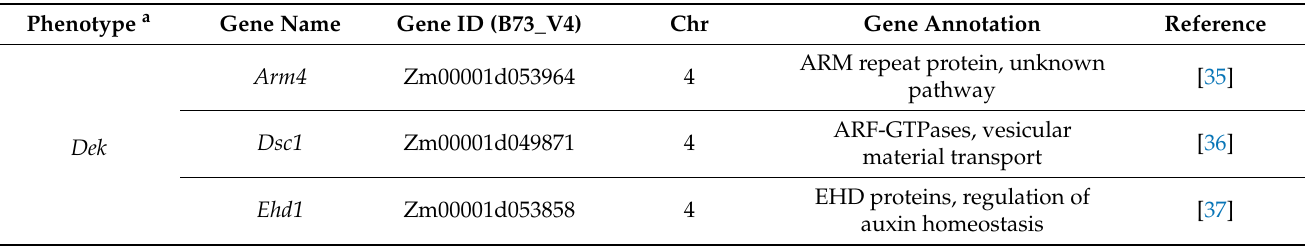
Table 1. Summary of cloned genes involved in maize kernel size .